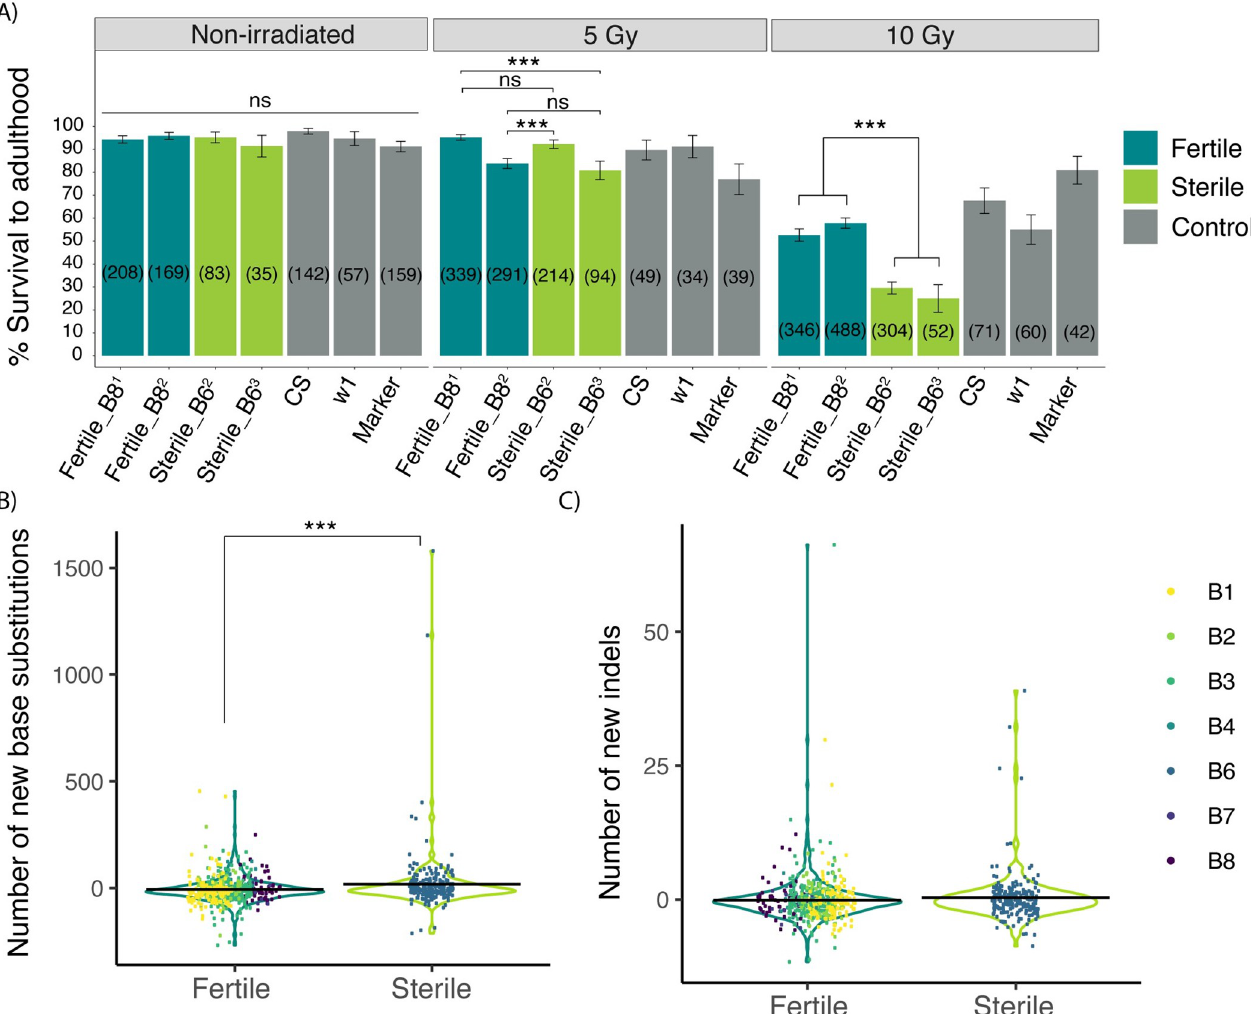
Fig 5. Sterile alleles exhibit reduced DNA repair. A) The percentage of mock treated and irradiated (5 Gy and 10 Gy) larvae that survived to adulthood for the fertile (B8), sterile (B6) and the control genotypes. CS refers to Canton-S and marker refers to the multiply marked stock b cn (#44229), which was used to generate isogenic lines. The numbers in the brackets refer to the sample size. The significance of comparisons between genotypes was determined by the χ 2 test-of-independence. B and C) New mutations that accumulate in RIL genomes as detected by MSG. B) New SNPs and C) new indels. An excess of new mutations was detected by a t-test comparing Sterile B6 RILs to all others. The data represented in the Fig is provided in S19 and S20 Tables) �� denotes P < 0.01, ��� denotes P <